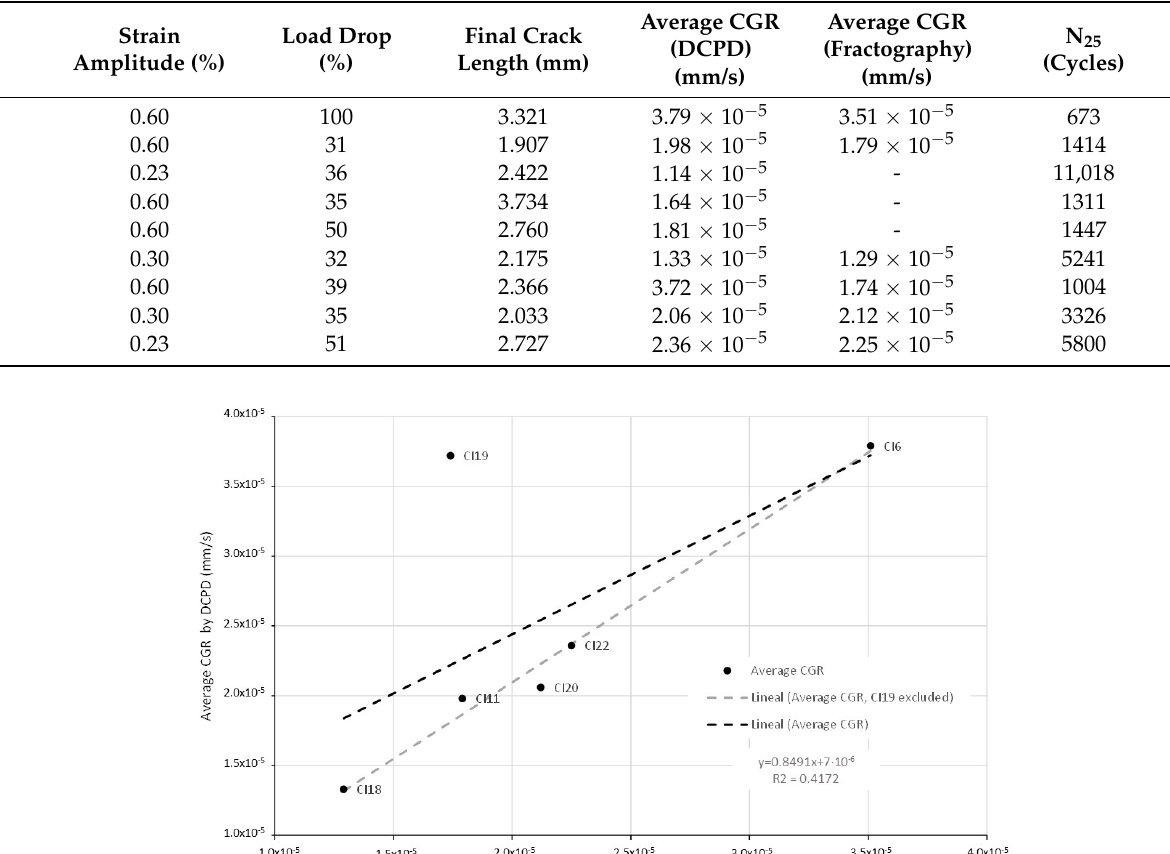
Table 4. Some test parameters and resulting crack growth rates calculated using the DCPD signal